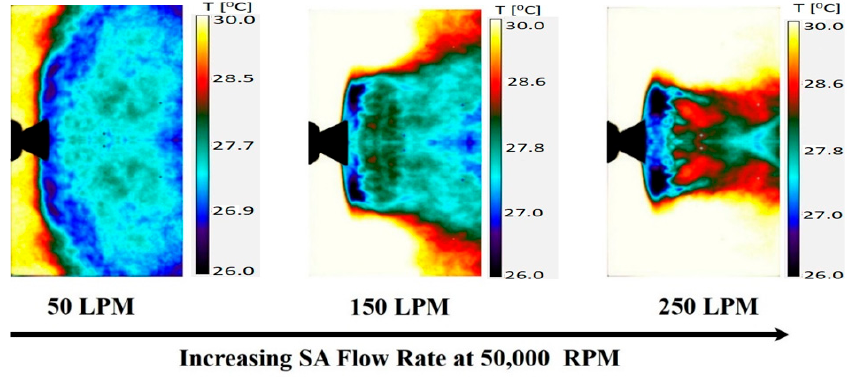
Figure 13. Infrared image of the ERBS Spray, showing increasing SA flow rate at a fixed bell cup rotational speed of 50,000 RPM and liquid flow rate of 0.1 LPM.